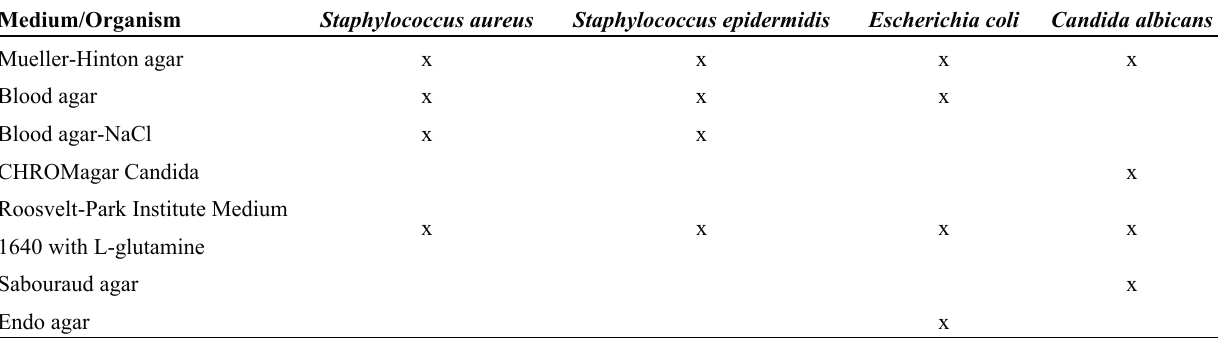
Table 1. Cultivation of microorganisms using different culture media (x = used for the given organism).